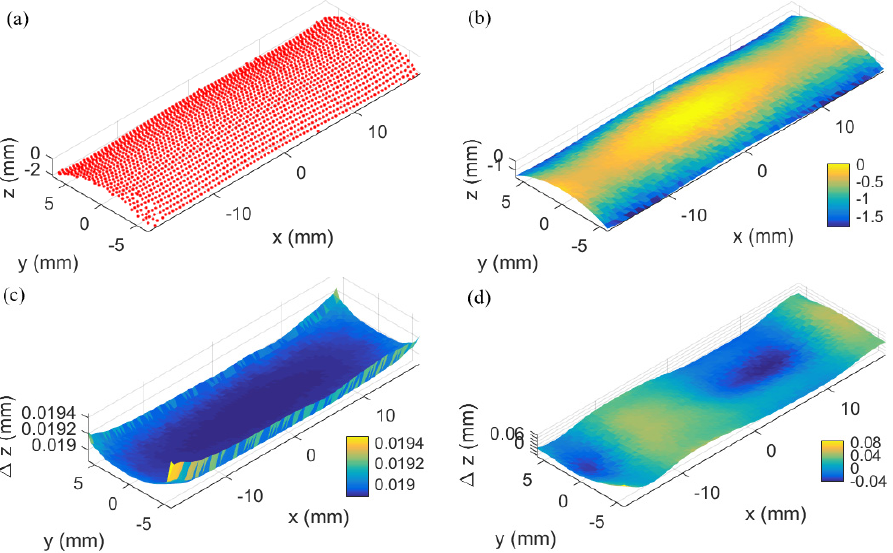
Figure 24. Measurement data and Gaussian process result: ( a ) raw data of measurement with the laser sensor; ( b ) mean surface; ( c ) associated uncertainty for the laser sensor; and ( d ) deviation of the mean surface from the reference data.